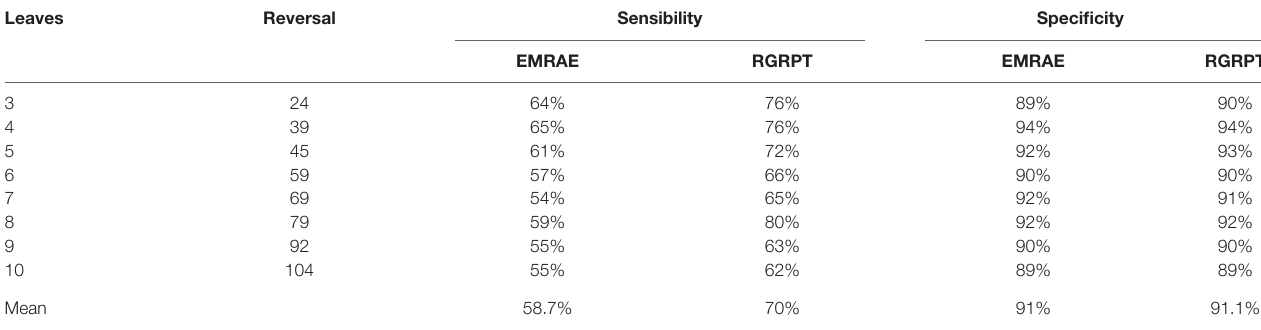
TABLE 1 | Results of EMRAE and recovering the genome rearrangements based on phylogenetic tree algorithms in predicting reversal events. Leaves Reversal Sensibility